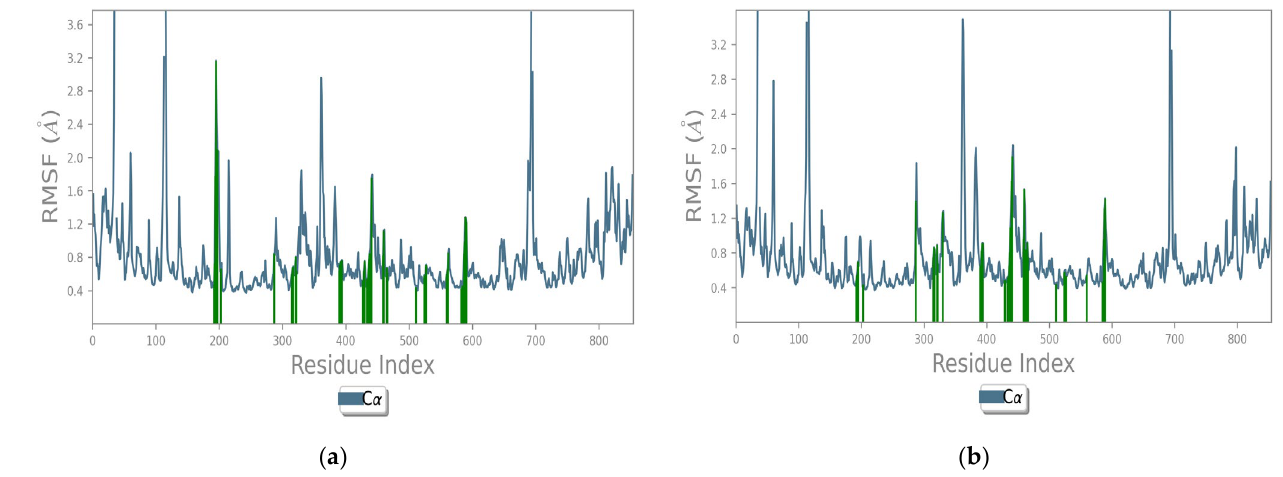
Figure 4. RMSF plot of Tradescantia pallida ’s compounds with human α -glucosidase protein 5NN5: ( a ) FTP1 and ( b ) FTP2; FTP1 is morin, FTP2 is catechin.